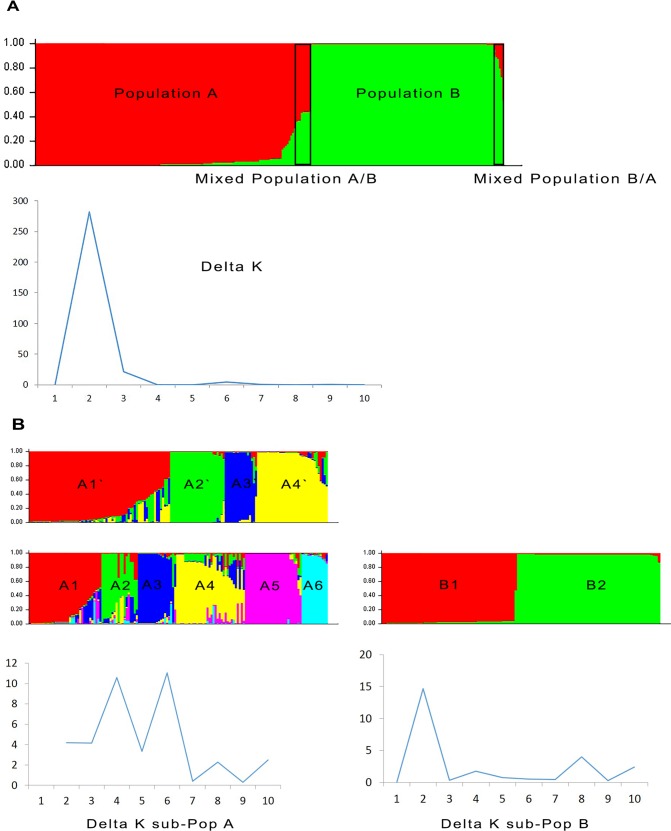
Estimated population structure for L. infantum from Southeastern France assessed using STRUCTURE software based on the analysis of the 270 L. infantum DNA samples at 12 microsatellite markers.A: The plots show the estimated membership coefficient (Q) of each isolates. Each isolate is represented by a single vertical line divided into K colors, in which K is the number of populations assumed. Each color represents one population, and the length of the colored segment shows the estimated proportion of isolates membership in that population. The derived graph for delta K shows K = 2, thereby indicating the presence of two populations in the investigated sample set. B: Isolates of the sub-populations A and B with delta K values for each sub-population. Two close values were observed for K in sub-population A: K = 4 and K = 6. For sub-population B, K = 2.